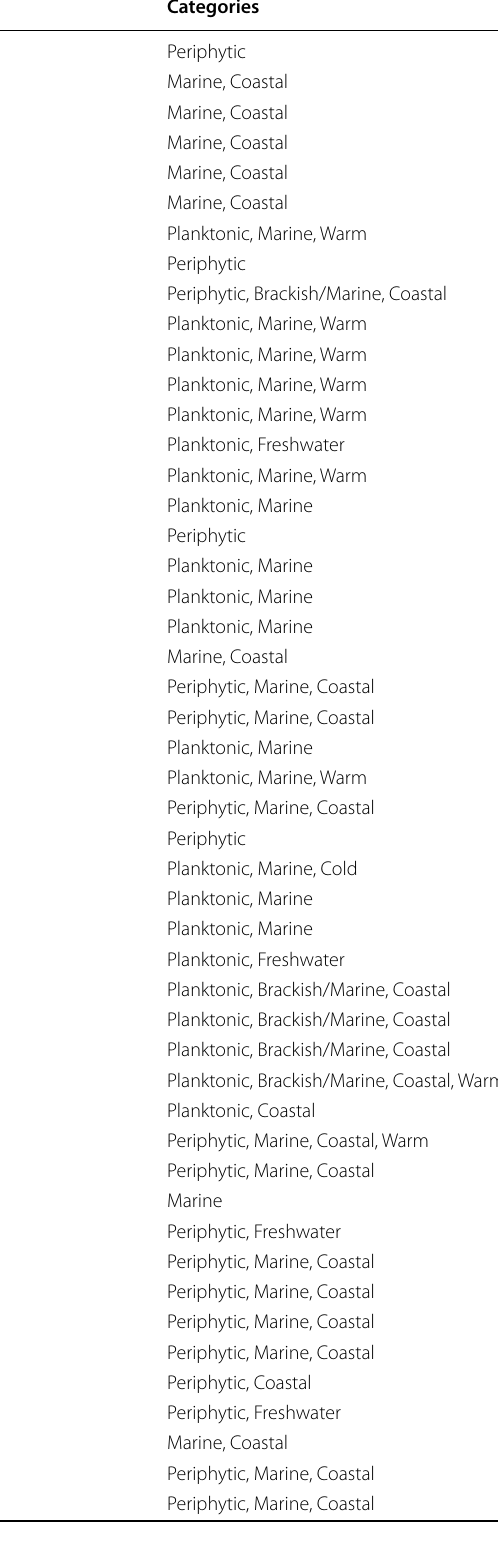
Table 2 Diatom taxa identified in Core KY07-04 PC01 with their ecological distributions Diatom